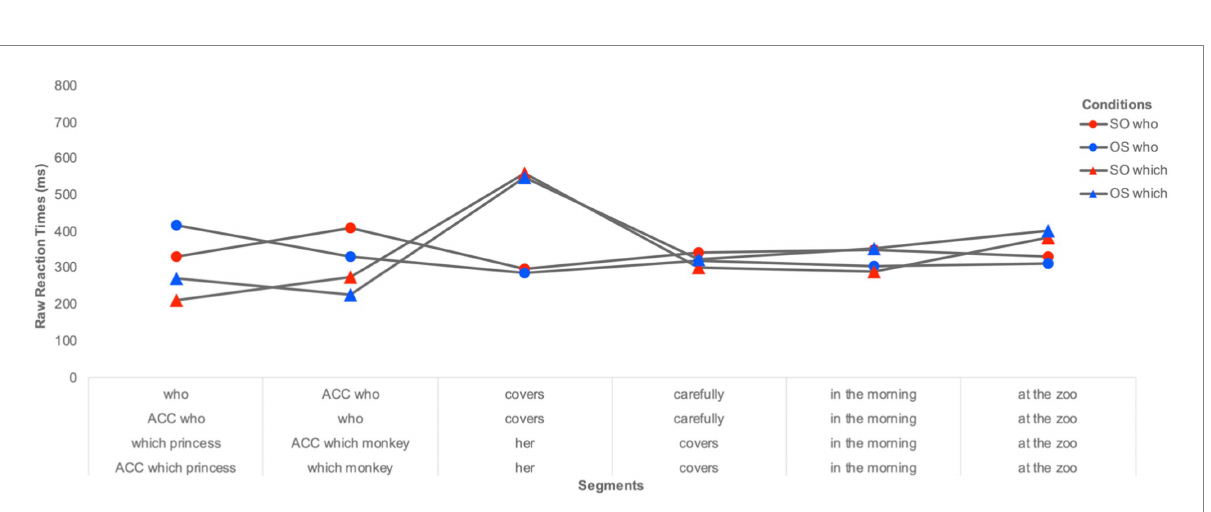
FIGURE 3 Segment-by-segment distribution of residual RTs per wh-type ( who vs. which ) and per wh-order (SO vs. OS) for heritage Romanian